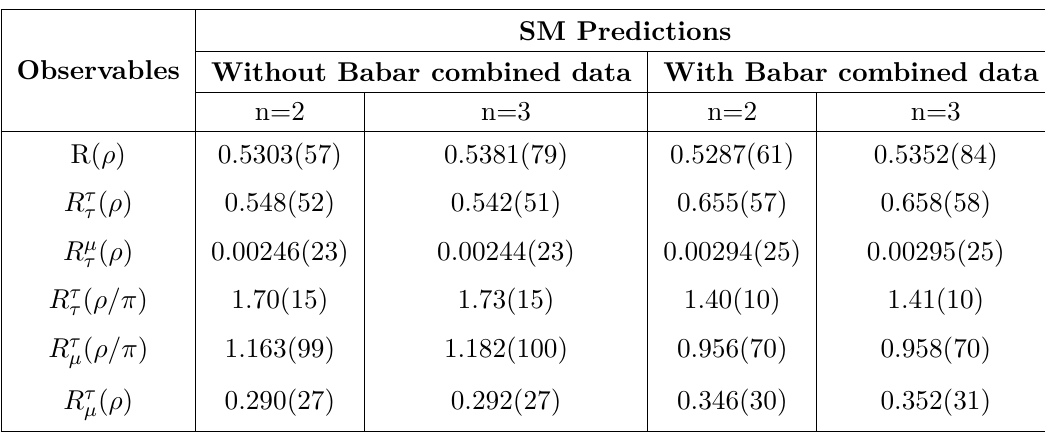
( ρ / π ) and R τ ( ρ / π ) the full τ µ